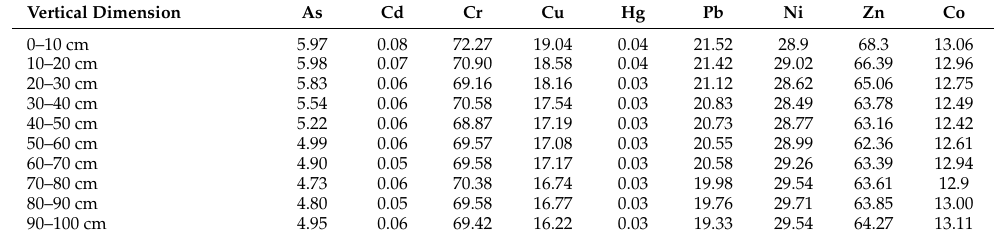
Table 3. Heavy metal concentration statistics of sediments (mg/kg).